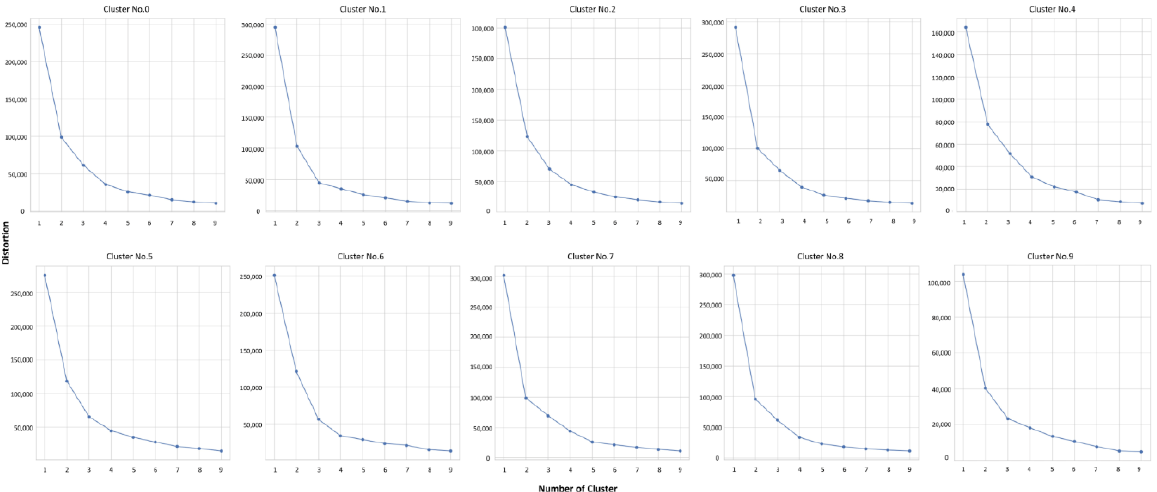
Figure 9. Boxplot of LOF of subsets.